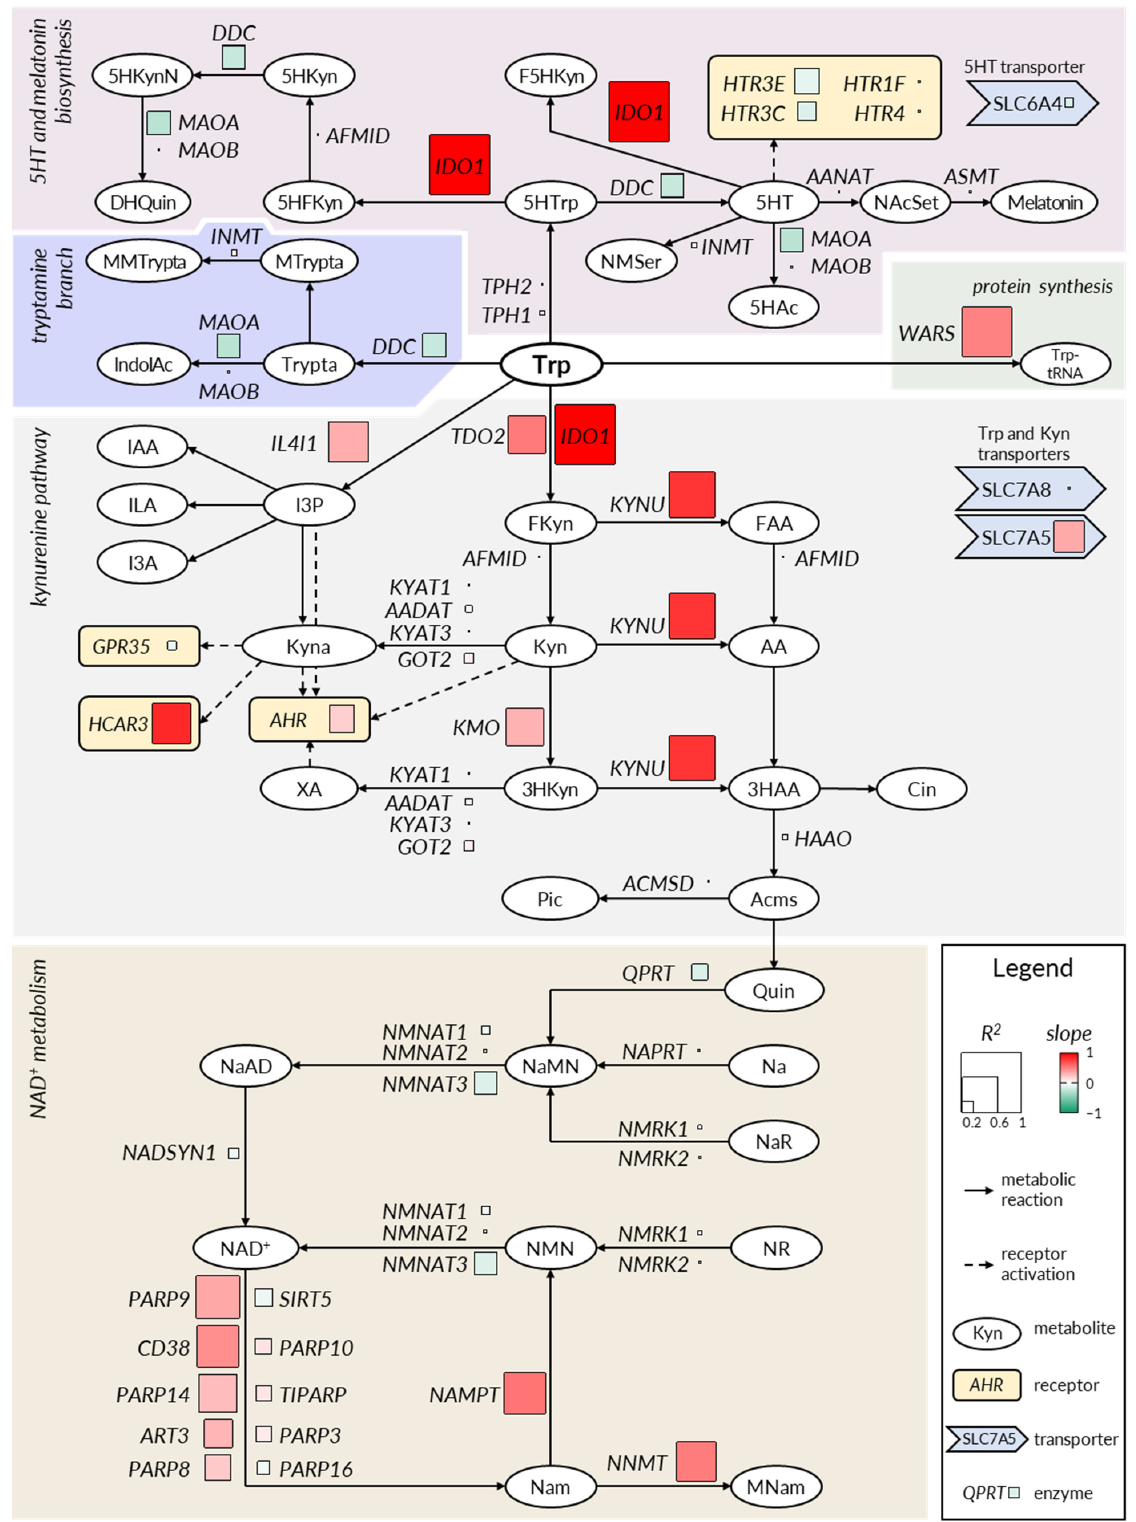
Figure 2. Pathways of tryptophan metabolism. Linear regression of log 2 fold-change of IDO1 gene expression ratios vs. other genes related to tryptophan metabolism along kynurenine pathway was calculated and marked with squares of varying size (denoting R 2 values) and color (indicating slope). Metabolites: AA, anthranilic acid; Trp, tryptophan; Kyn,